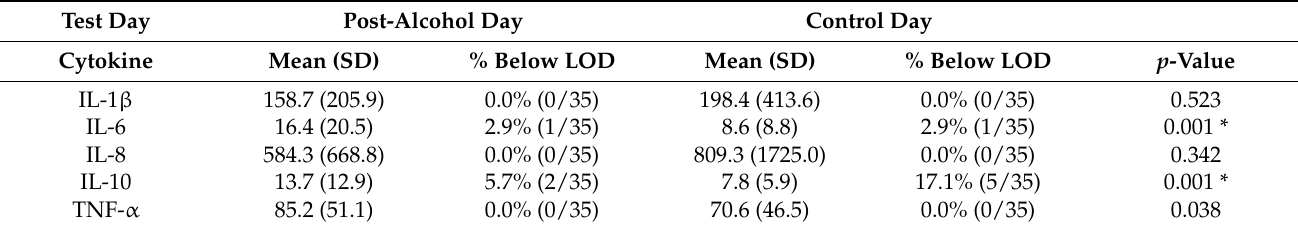
Table 2. Mean (SD) saliva cytokine concentrations of all